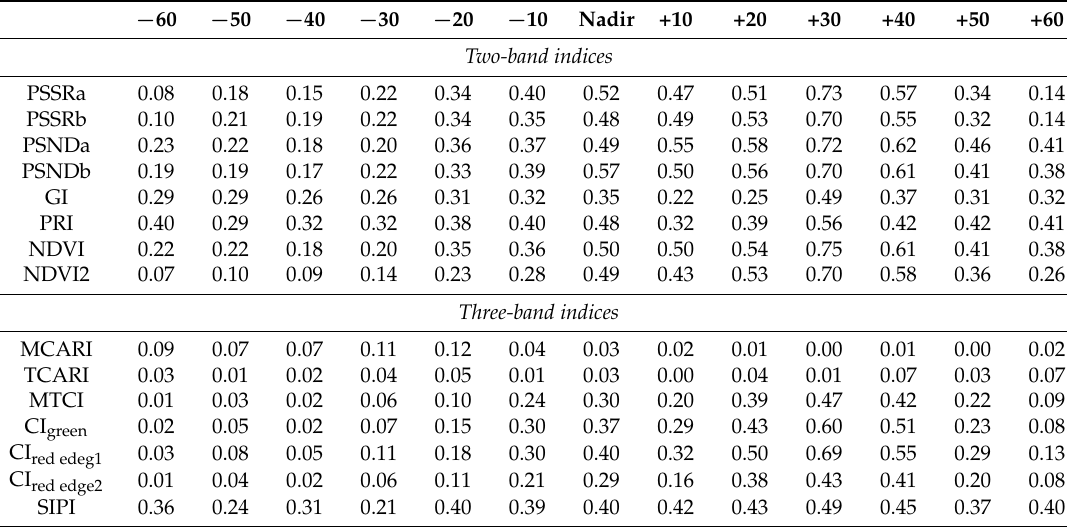
Table 3. Coefficients of determination (R 2 ) between published spectral indices and leaf Chl content in the middle-layer of wheat canopy at different viewing angles.